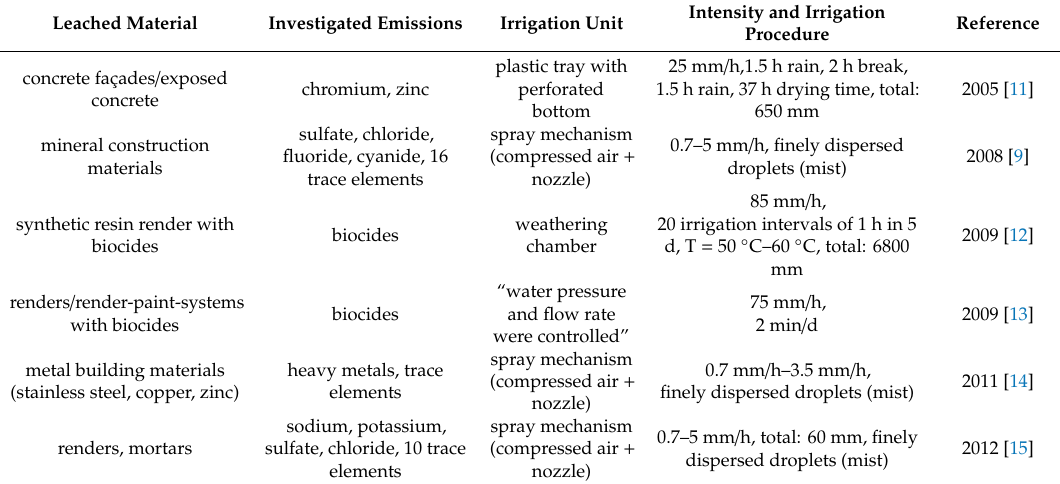
Table 1. Overview of previous research projects with laboratory